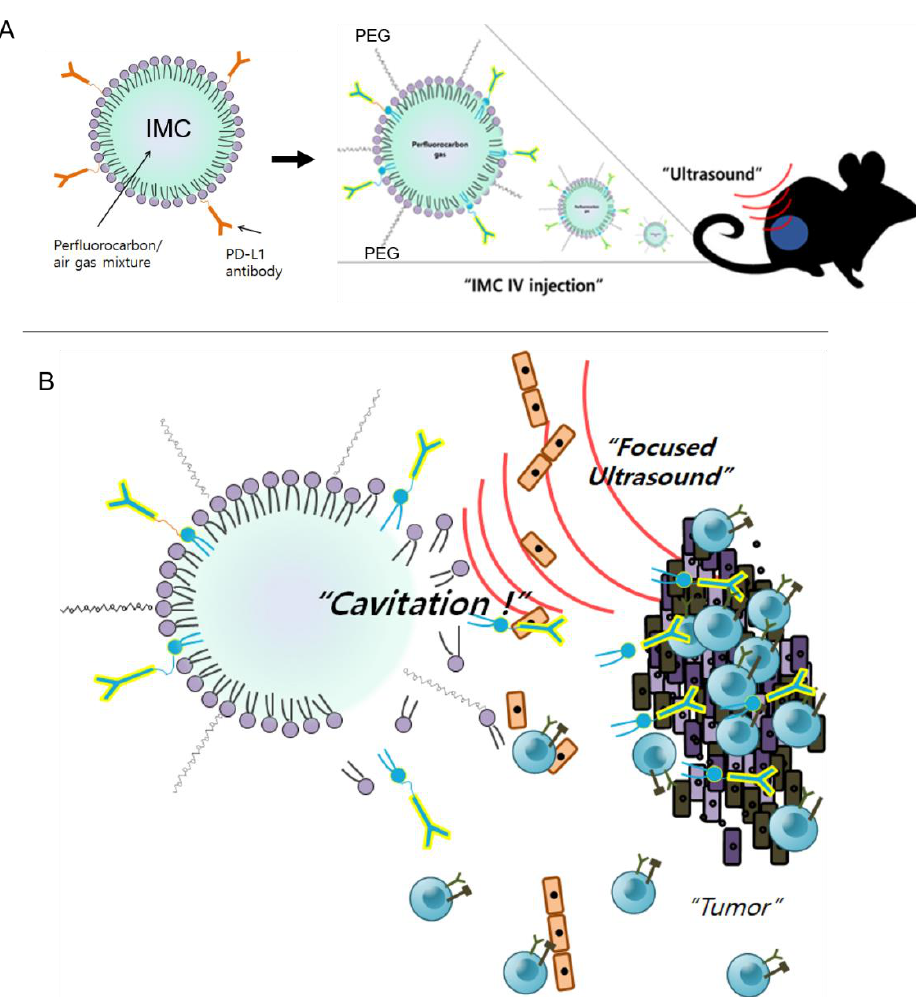
Figure 7. The proposed mechanism of action for IMC and the combination therapy. ( A ) IMCs are injected intravenously into the tumor-bearing mice. Because they are PEGylated and larger in size, they are less likely to induce immune responses compared to the individual antibodies. ( B ) IMCs are stimulated with ultrasound, which causes acoustic cavitation as well as their breakdown, allowing the PD-L1 antibodies to better access the tumor. The blocking of the surface PD-L1 on the tumors allows cytotoxic T cells to recognize the tumor cells and destroy them.